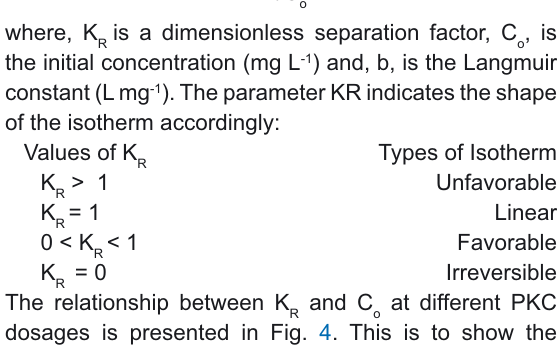
determinations (r 2 = 0.8707 and 0.9604, respectively),